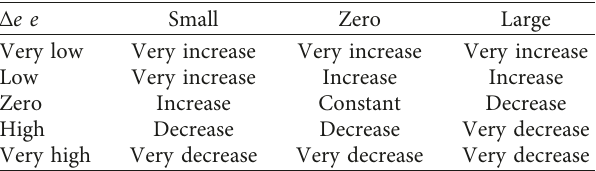
Figure 20: FLC’s (Fuzzy Logic Controller) block diagram. Table 2: Fuzzy control rules.